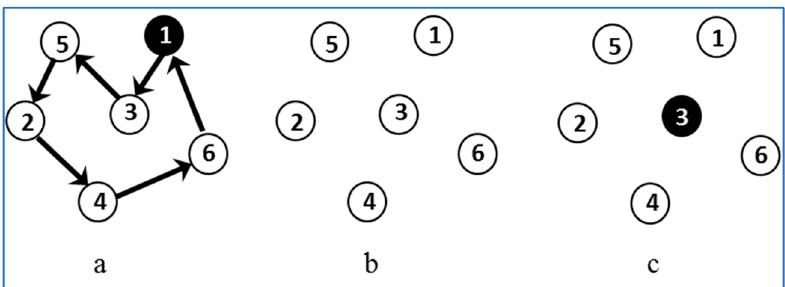
Figure 5. The collecting center removal operator. ( a ) The current solution: number 1 is the collecting center. ( b ) Close collecting center number 1. ( c ) Choose number 3 as the new collecting center.